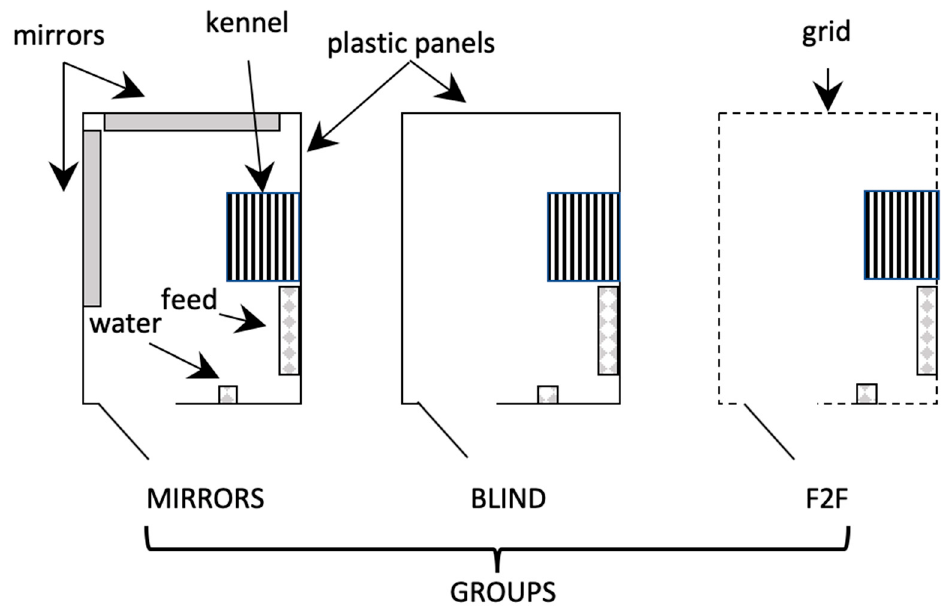
Figure 1. Design of the pens for mirrors, blind and face to face (F2F) groups. Each pen hosted three rabbits for nine replicates (27 rabbits for each group).